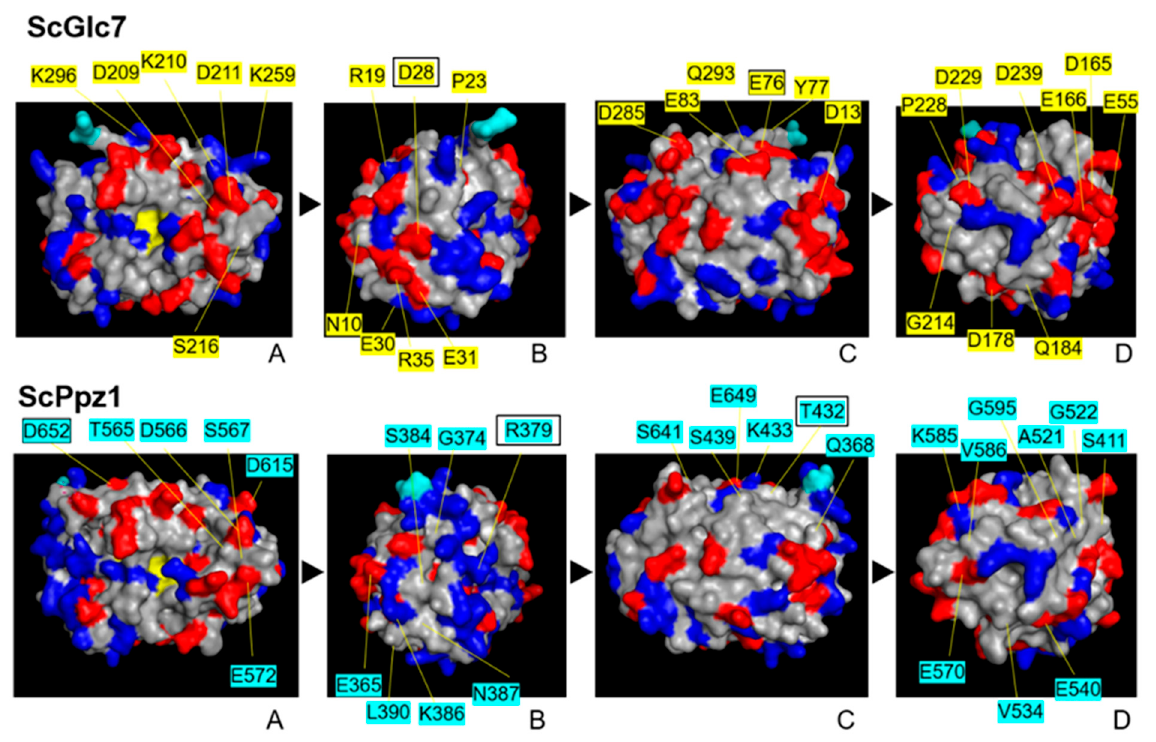
Figure 4. Distribution of changes affecting charged residues on the surface of both Glc7 ( upper panel ) and the catalytic region of Ppz1 ( lower panel ). Mapped residues represent potential alterations in surface charges in PP1 or PPZ enzymes. Acidic residues are in red and basic ones in dark blue. Boxed residue names are changes present in S. cerevisiae Glc7 or Ppz1 but not necessarily in most other species. The C-terminal modeled residue of Glc7 and Ppz1 are depicted in cyan to facilitate identification. A to D denotes the positions after 90 ⁰ anticlockwise rotation on the Y -axis.